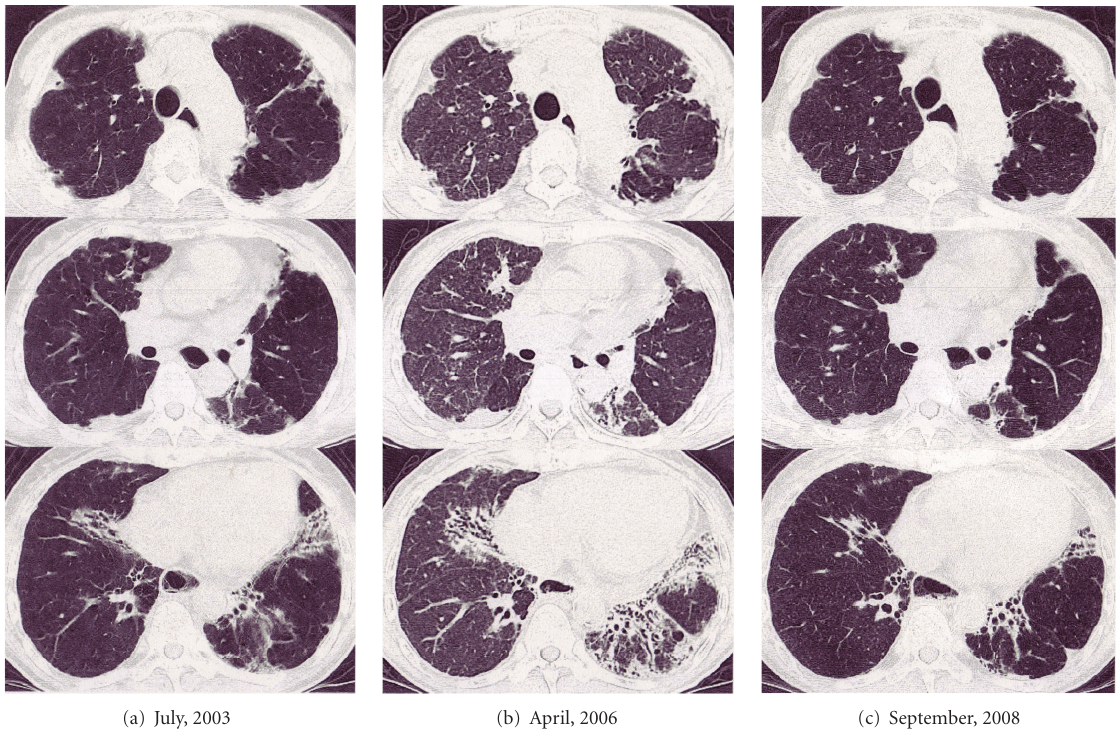
Figure 2: Course of chest HRCT. (a) Consolidations, ground-glass opacities (GGO), and traction bronchiectasis (TBE) were noted on chest HRCT at July, 2003. (b) Consolidations, GGO, and TBE increased on admission in April, 2006, compared with that in April, 2003. (c) Consolidations, GGO, and TBE improved with 10mg/day of prednisolone and 75 mg/day of azathioprine at September,